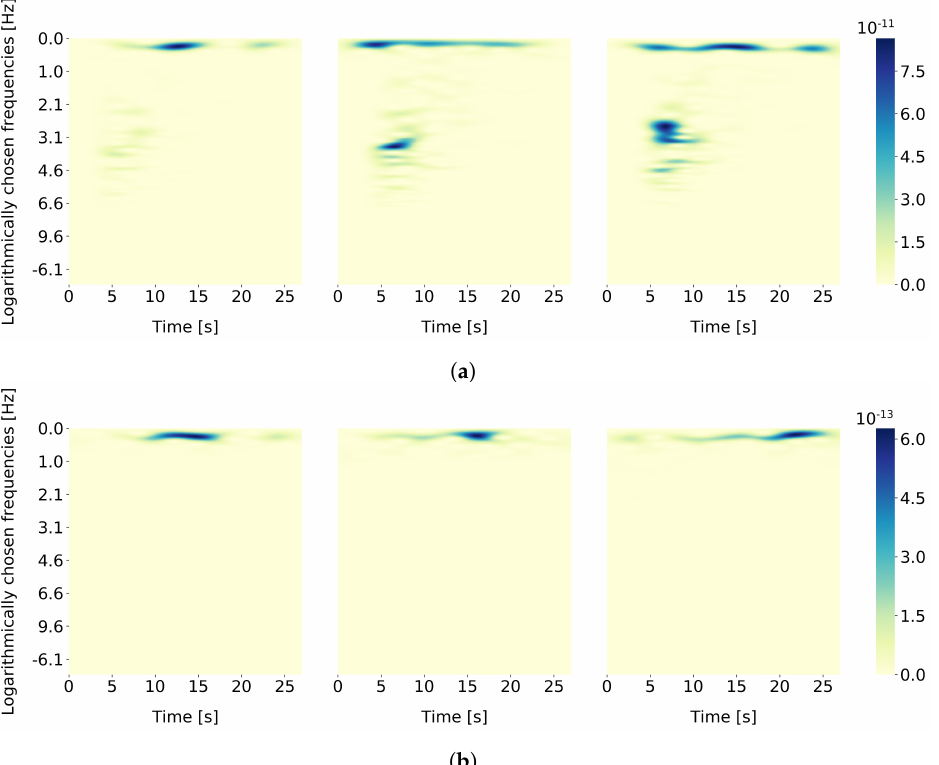
Figure 6. Spectrogram transformations of ( a ) an earthquake and ( b ) noise shown in Figure 2. All three axes are